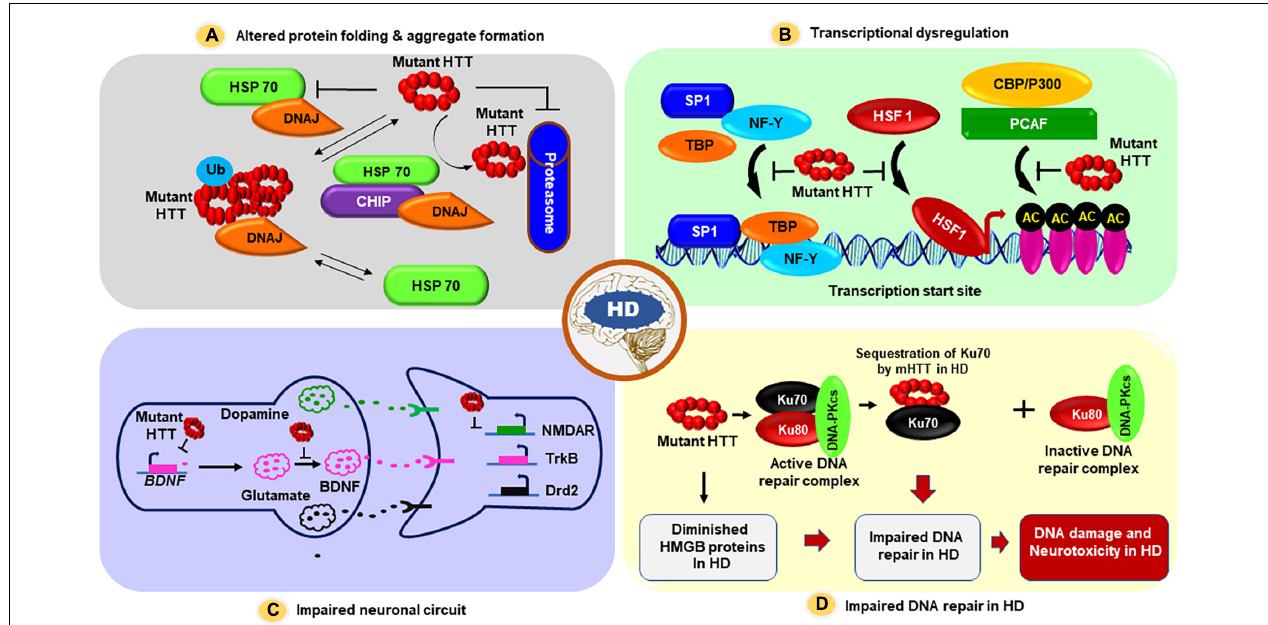
FIGURE 1 | The proposed mechanism(s) by which mHTT triggers neuronal dysfunction and neurotoxicity in HD. Several possible pathogenic mechanism(s) for HD have been proposed: (A) First, mHTT can adopt altered structural conformations, and these inappropriately folded structures may aberrantly interact with many neuronal proteins, and these unusual protein-protein interactions may result in protein aggregate formation, and these aggregates may physically interfere with the vesicle and organelle transport within the cells, triggering neurotoxicity in HD. These aggregates may also fully or partially inactivate numerous proteins that are sequestered into HTT aggregates in HD neurons, contributing to neurotoxicity and HD pathogenesis. (B) mHTT carrying expanded polyQ sequences cause transcriptional dysregulation in HD: The mHTT protein translocate into the nucleus, interacts with various transcription factors and cofactors, and interferes with their normal functions, resulting in aberrant transcription of many neuronal genes that regulate neuronal function, survival, synaptic function, and vesicle transport. mHTT-mediated transcriptional dysregulation ultimately results in neuronal dysfunction, neurotoxicity, and neurodegeneration at early stages of disease progression in HD; (C) Evidence also suggests that in addition to overt transcription dysregulation, mHTT may also impair neuronal circuits and interfere with neurotransmission and synaptic function causing early neurotoxicity in HD. Hypothesized model illustrating how changes to the cortical-striatal synapse during early-stages of HD. In response to mHTT expression expression of BDNF is reduced in HD. Glial glutamate uptake by glutamate transporter 1 (GLT-1) is reduced, which probably enhances synaptic and/or extrasynaptic glutamate levels. Postsynaptic N-methyl-D-aspartate receptors (NMDAR) are increased outside the synapses, and gamma-aminobutyric acid (GABA)-argic inhibitory input is enhanced and tyrosine kinase B (TrkB) signaling is reduced. (D) Evidence also suggests that mHTT aberrantly interacts with and sequesters Ku70, an essential factor in NHEJ-mediated DNA double-strand break repair in HD. Sequestration of Ku70 by mHTT results in impaired DNA double-strand break repair in HD. Moreover, mHTT can also repress the expression of high mobility group proteins B1 and B2 (HMGB1/2), and mHTT-mediated downregulation of HMGB1/2 proteins can also result in defective DNA repair and DNA damage accumulation in HD. Abbreviations: SP1, Specificity protein 1; TBP, TATA binding protein; NF-Y, Nuclear factor Y; HSF1, Heat shock transcription factor 1; CBP, CREB-binding protein; AC, Acetylation; HSP70, Heat shock protein 70; DNAJ, Chaperone protein; Ub, Ubiquitination; BDNF, Brain-derived neurotrophic factor; NMDAR, N -methyl- D -aspartate receptors; TrkB, Tropomyosin receptor kinase B; Drd2, Dopamine Receptor